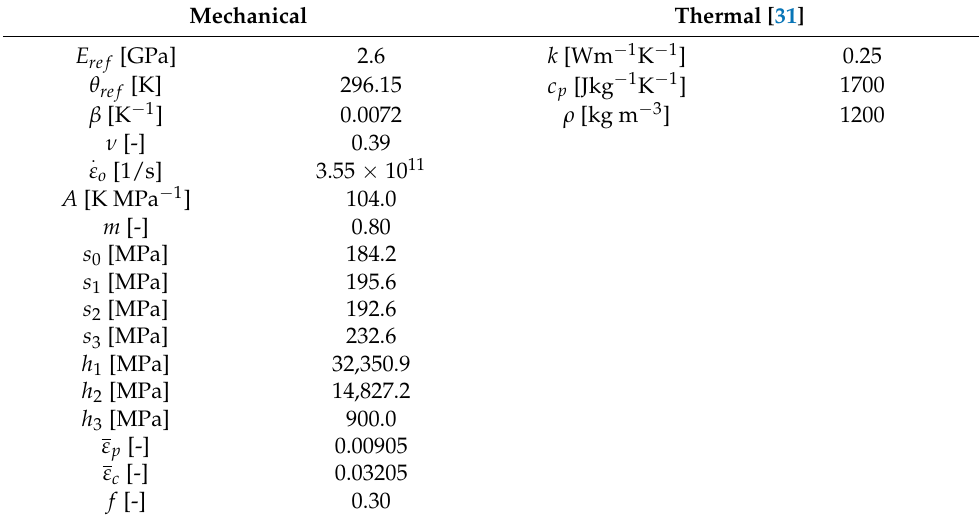
Figure 3. USCP model considering two saturated states ( a ) fitting of crystalline related parameter and ( b ) model validation using dog-bone test. Table 2. Properties of PA6